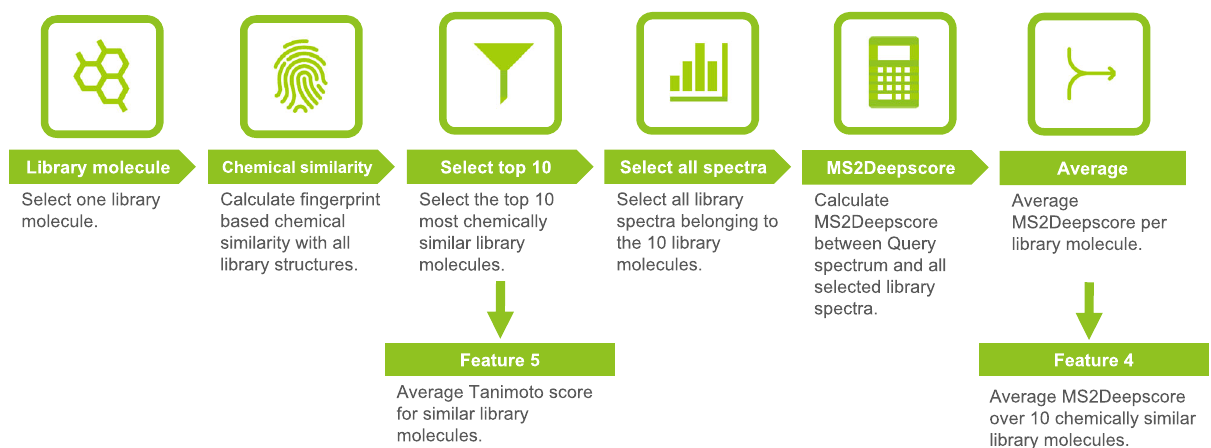
Fig.4|Work fl owforcalculatingtwoinputfeaturesoftherandomforestmodel. Feature5istheAverageTanimotoscoreforsimilarlibrarymoleculesandfeature4is the average MS2Deepscore over 10 chemically similar library